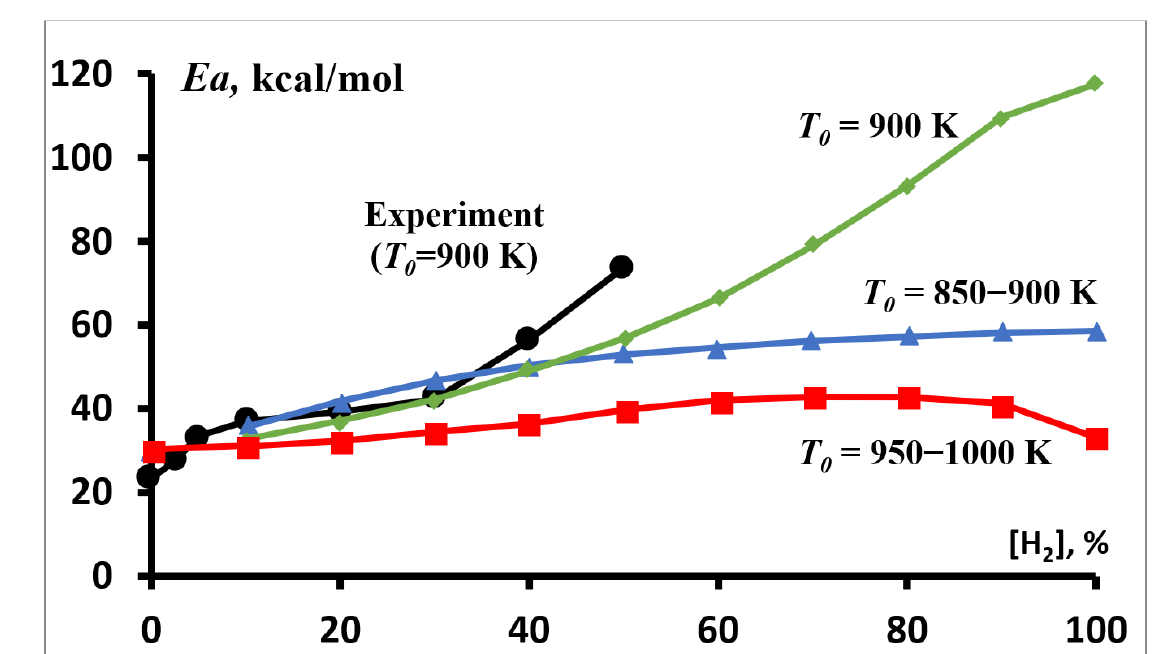
Figure 7. Dependence of the effective activation energy E a for the autoignition delay time of stoichio- metric methane–hydrogen–air mixtures on the hydrogen concentration at P 0 = 1 atm. • —experimental results ( T 0 = 900 K). Calculations at T 0 (K) 850 – 900 ( ▲ ), 900 ( ♦ ) and 950 – 1000 ( ■ ).